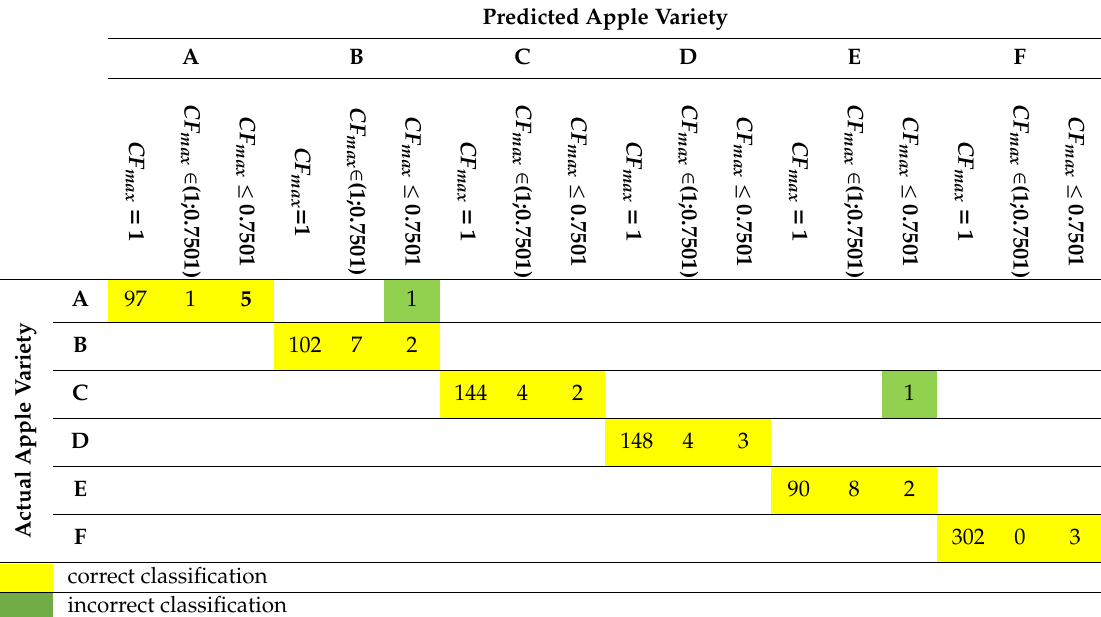
Table 8. Results of apple variety classification related to actual apple